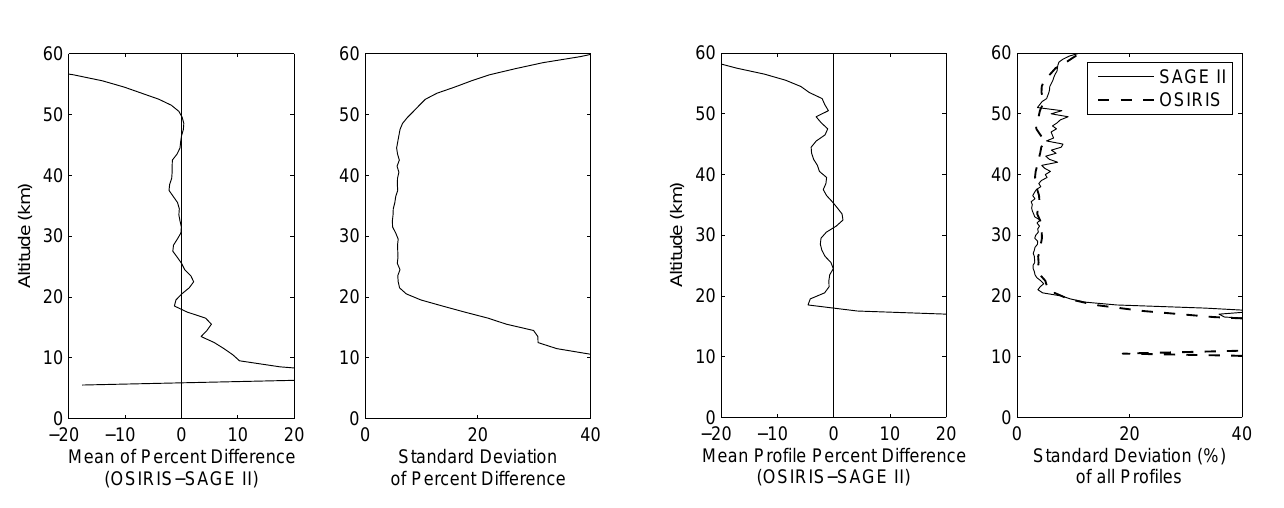
Fig. 5. A selection of single profiles that meet the coincidence criteria. Profiles are shown at their inherent vertical resolution. The entire data set consists of 196 coincidences.